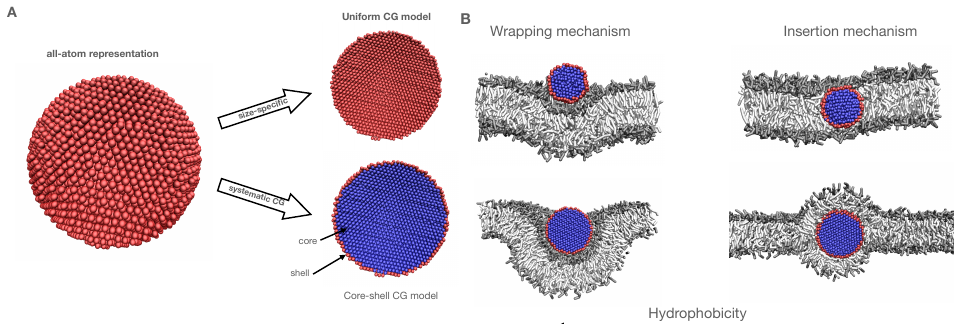
Figure 1. ( A ) Possible CG representations of a NP. In each case, one Ag atom is mapped to one CG bead and all surface beads make up the shell domain, while all other beads make up the core domain. In the core-shell representation, beads in shell and core domains may be of a different Martini type, while in the uniform representation, core and shell beads always are of the same type. Ag atoms are drawn red, while different bead coloring in the CGMD representation highlights the difference in Martini interaction types. ( B ) Representative CG snapshots of the two mechanisms observed in our simulations. The type is regulated by the overall NP hydrophobicity: wrapping (B, left) and insertion ( B , right). Top and bottom rows illustrate the effect of relative size in the two mechanisms: (top) 3 nm NP, slightly smaller than the membrane thickness, (bottom) 5 nm NP, slightly bigger than the membrane thickness. As the nature of the lipids is not crucial at this stage, all hydrophobic domains of lipids are shown as white sticks, while the hydrophilic domains are shown as grey sticks. The NP representation is the same as in the core-shell CG model of panel